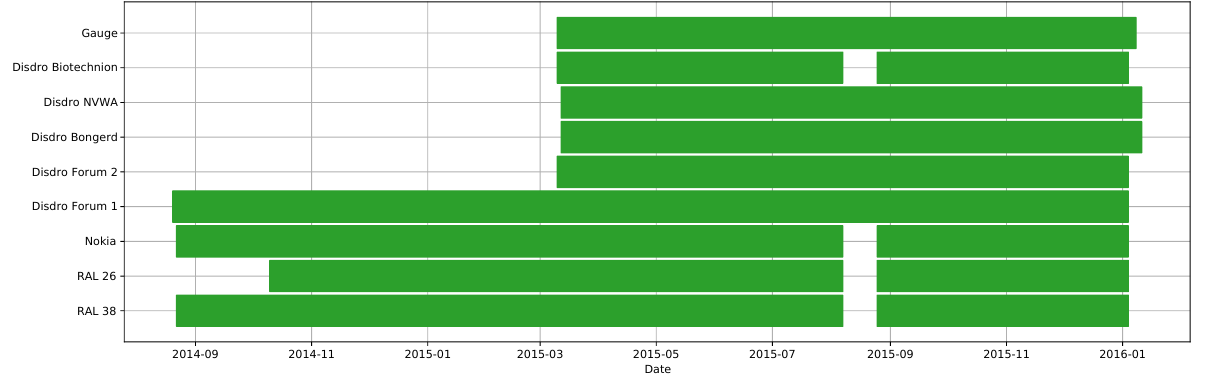
39.43625 GHz in the other direction. The bandwidth of the signals is 0.9 MHz. The device transmits and receives only horizontally polarized